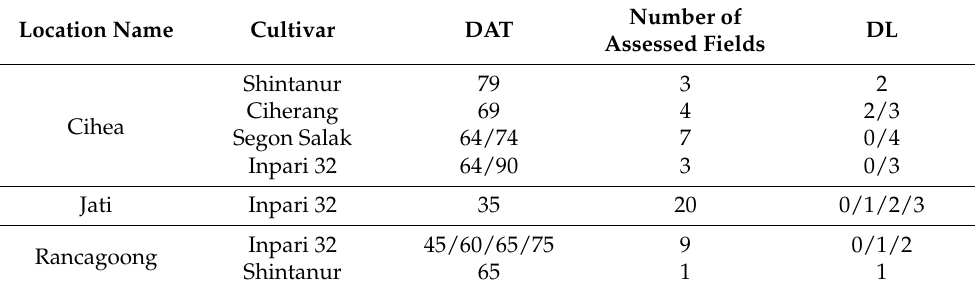
Table 3. Details of information on the third survey in 2021.